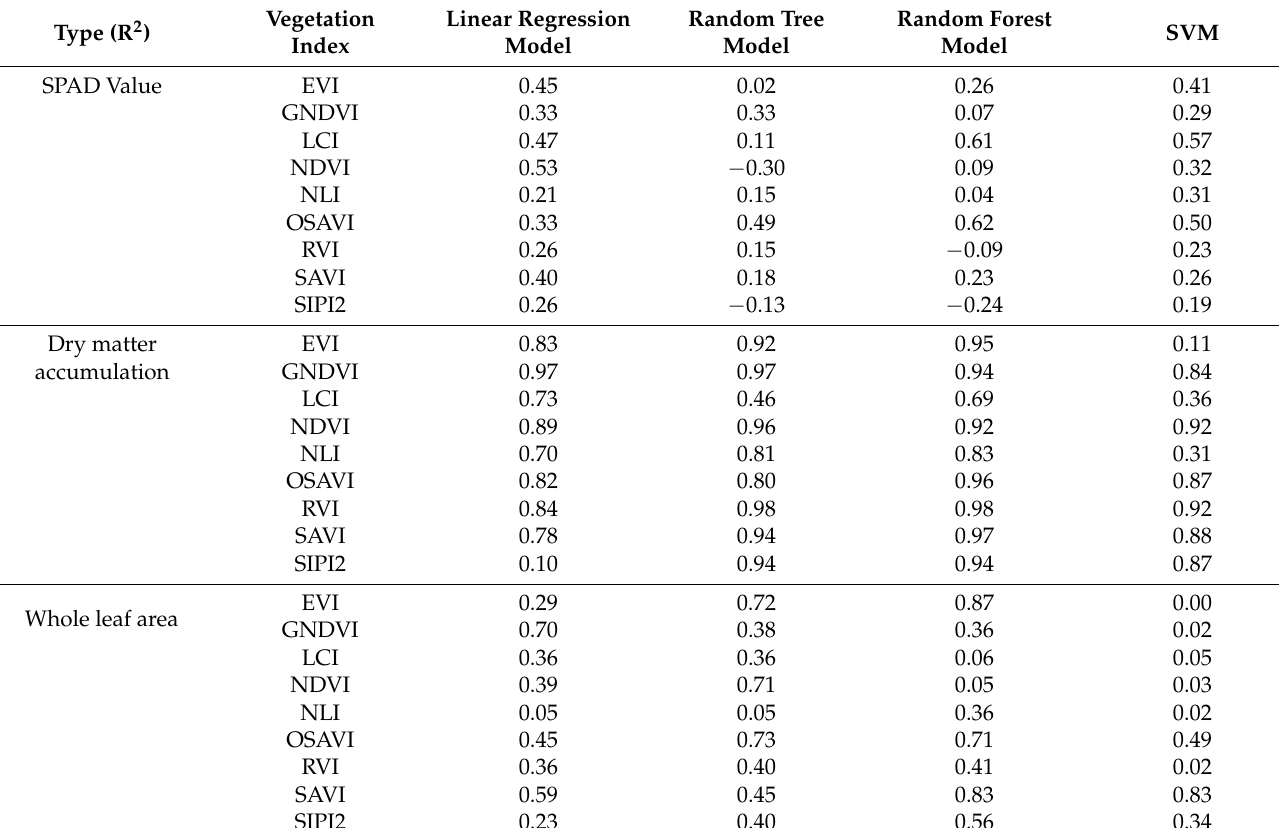
Table 4. Regression modeling of rice physiological parameters with vegetation index.